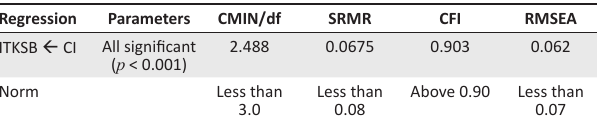
TABLE 6: Model fit